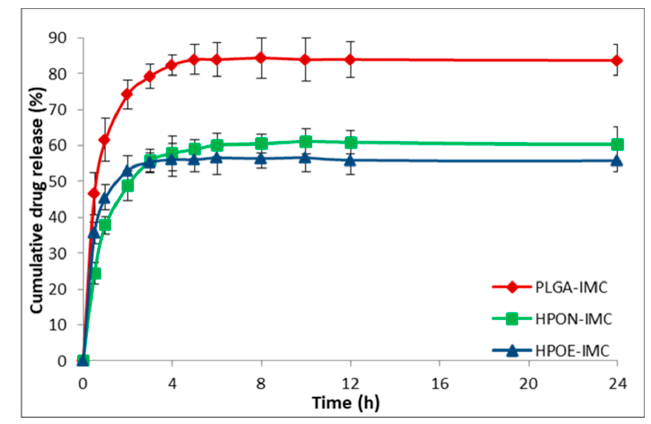
Figure 6. In vitro release profile of IMC from plain or hybrid uncoated formulations.